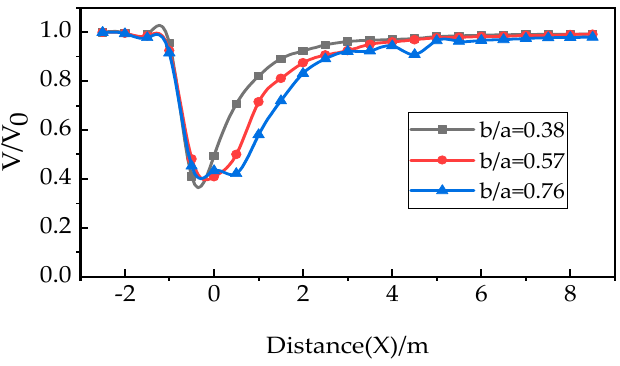
Figure 16. Relative velocity comparison curve with different ratios of the major axis to the minor axis.